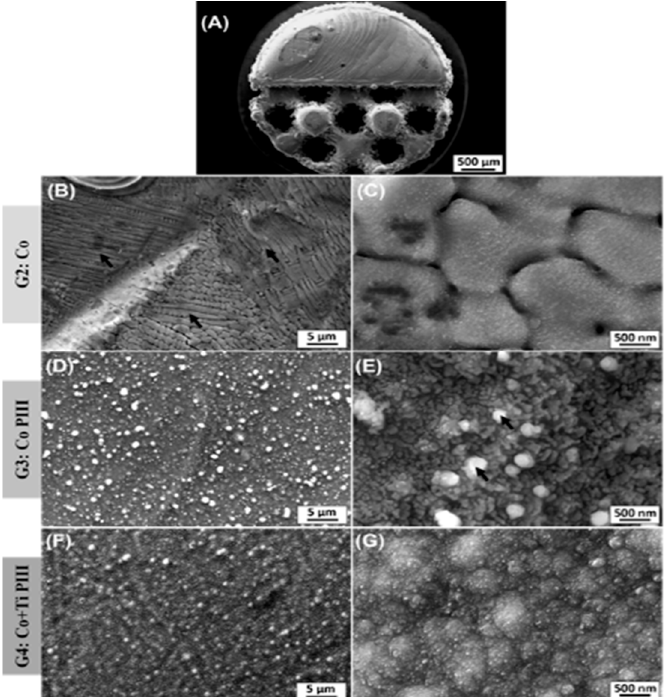
Figure 3. Scanning electron microscope (SEM) images of various surface finishes. Overall view from the as-built AM implant ( A ). As-built surface ( B , C ). Nanostructured and anodized by the PIII surface ( D , E ). Coated with Ti and nanostructured and anodized by the PIII surface ( F , G ). Black arrows in ( B ) indicate dendritic arms and in ( E ) spherical